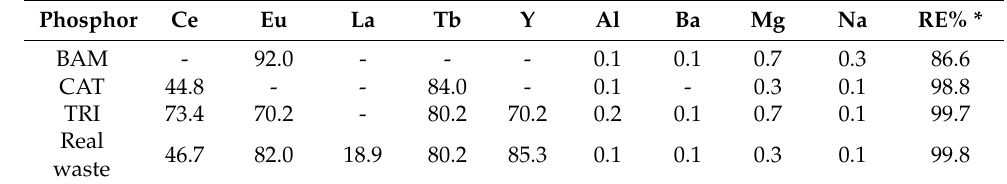
Table 3. Supercritical fluid extraction efficiency (EFF%) of each metal from the calcined phosphors. Phosphor Ce Eu La Tb Y Al Ba